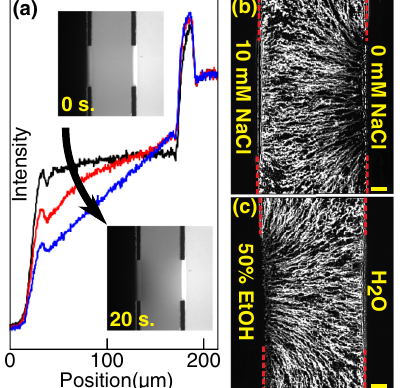
FIG. 7. Concentration gradients created locally within micro- channels. (a) Direct gradient visualization with Oregon Green fluorescent dye at 0 (black), 10 (red), and 20 (blue) seconds after stopping flow. Panel (b) and Video 7: Diffusiophoretic motion of fluorescent colloids up a NaCl gradient. Panel (c) and Video 8: Solvophoreticmotiondownanethanolgradient.Scalebar: 20 (cid:1) m